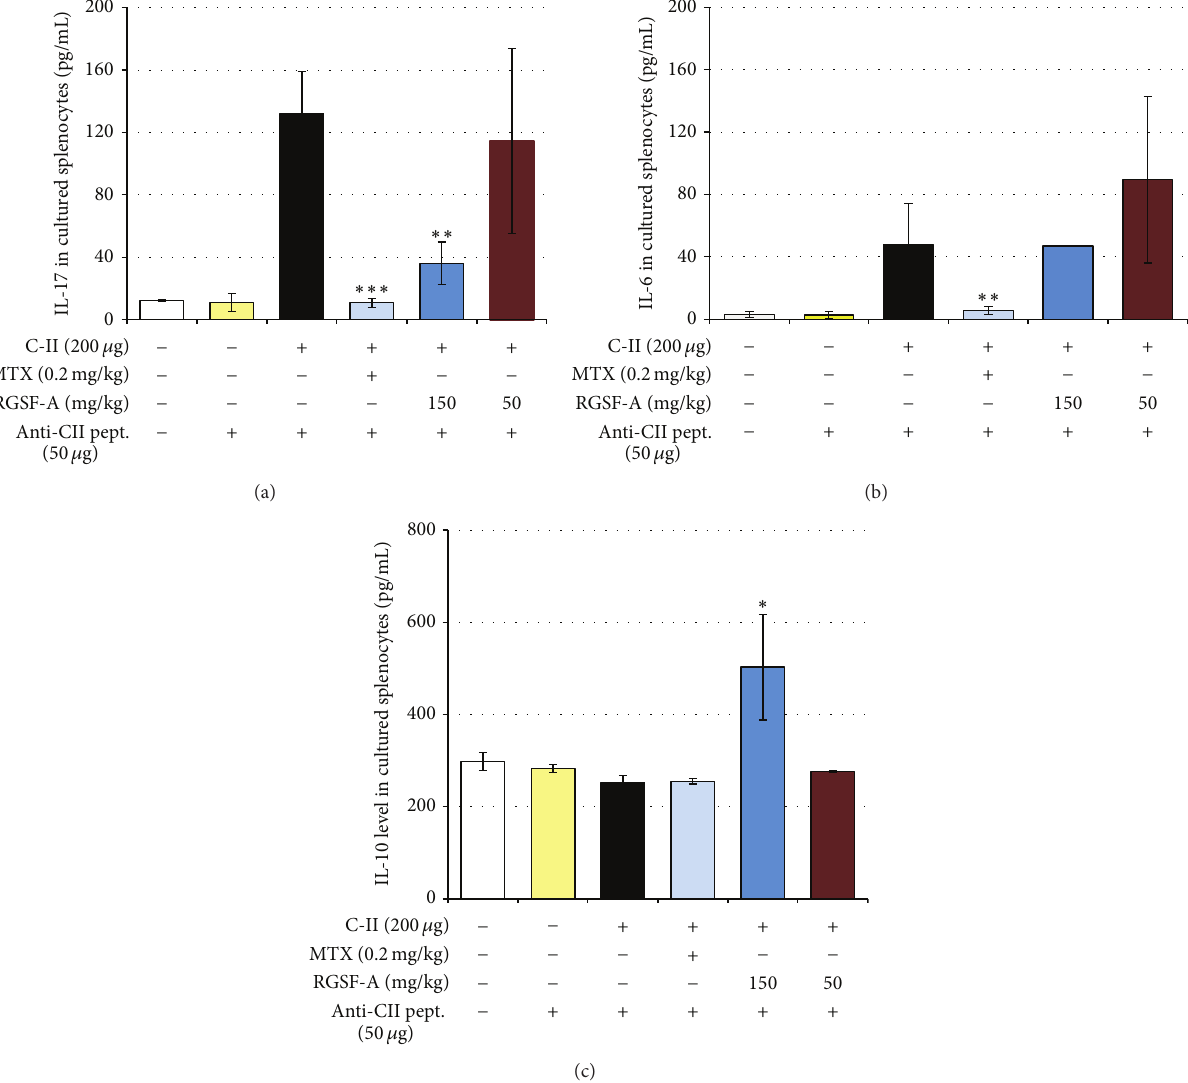
Figure 7: Effect of RGSF-A on cytokine production profile in cultured and anti-CII peptide stimulated splenocytes isolated from CIA mice. Splenocytes from na¨ıve, RGSF-A, MTX, or vehicle-treated mice isolated, cultured, and collagen peptide stimulated followed by analysis of cytokine levels in the supernatant as indicated in the materials and methods section. Treatment of RGSF-A at higher dose reduced CIA IL-17 (a) and IL-6 (b) secretions but induced IL-10 production in splenocytes from CIA mice cultured with anti-CII peptide. ∗ 𝑃 < 0.05 , ∗∗ 𝑃 < 0.01 , and ∗∗∗ 𝑃 < 0.001 as compared with vehicle treatment; 𝑛 = 6 for each